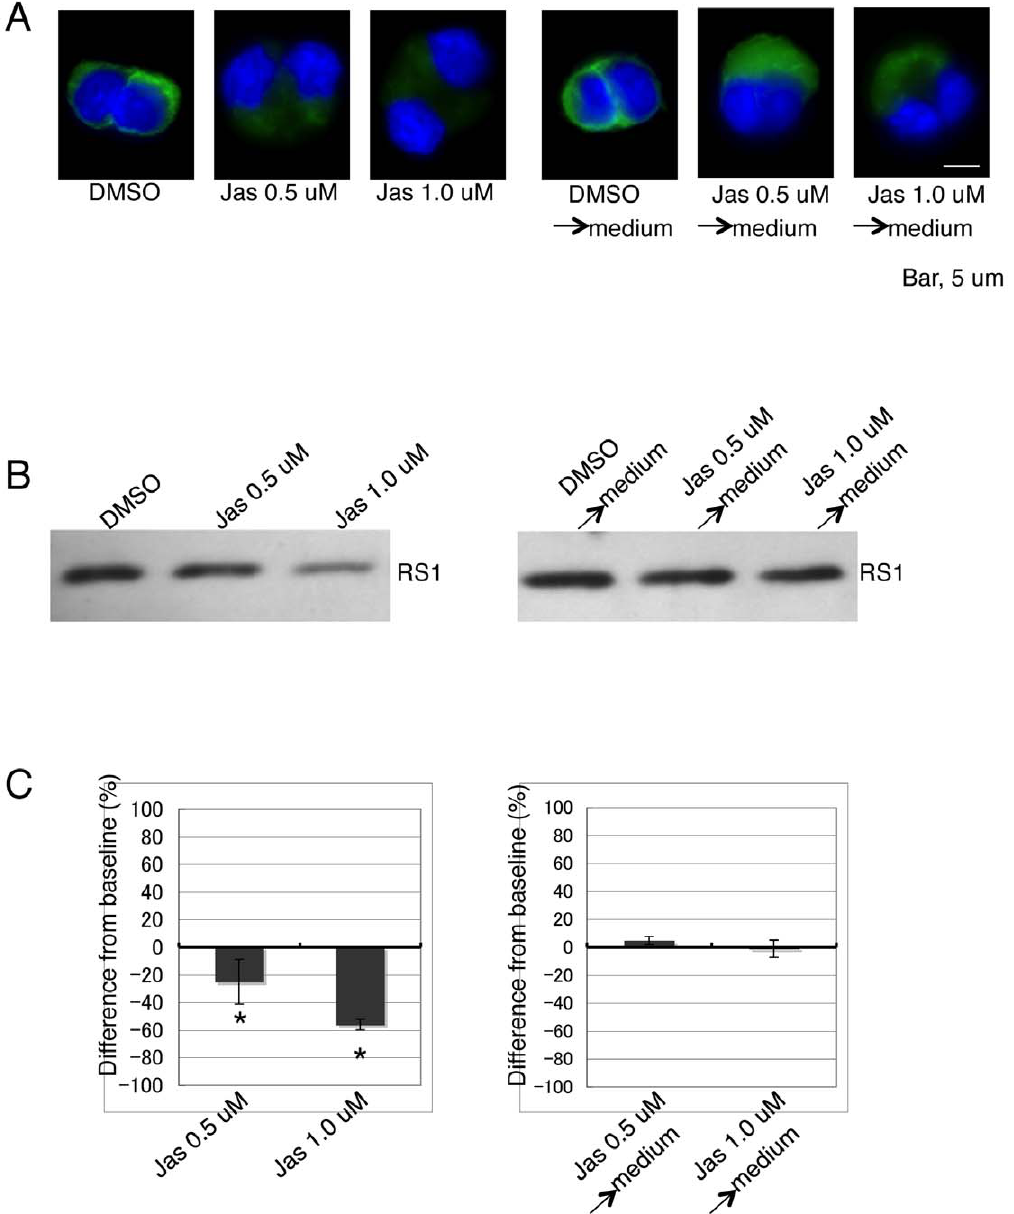
Figure 5. The effect of jasplakinolide on retinoschisin secretion is reversible. (A) The F-actin cytoskeleton was visualized by Alexa Fluor 488- phalloidin (green). Duplicate cell samples were treated with DMSO or 0.5 m M and 1.0 m M jasplakinolide (Jas) for 72 h and then one set was fixed and labeled for F-actin (left panel). The conditioned medium of the other set of samples was replaced by fresh medium without DMSO (DMSO R medium) or jasplakinolide (Jas 0.5 m M or 1.0 m M R medium) in it. Cells were incubated for another 72 h in the fresh medium, fixed, and labeled with Alexa Fluor 488-phalloidin. (B) Western blot of proteins from the medium of each sample described in (A). Retinoschisin was detected using the RS24-37 antibody. (C) Quantification of the intensity of each band on the Western blot in (B) (see MATERIALS AND METHODS). The data are means 6 SEM of three different biological samples for each condition. *: p , 0.05 was obtained for the difference between 0.5 m M or 1 m M jasplakinolide- and DMSO- treated